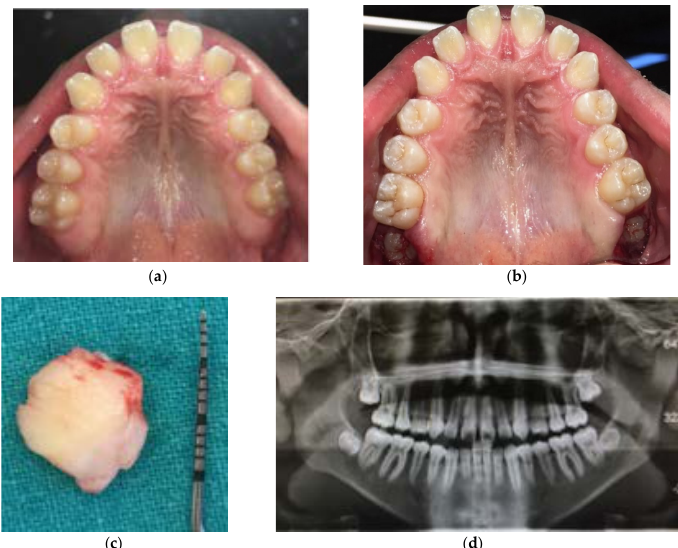
Figure 1. Example of a case treated with operculectomy. ( a ) Pre-surgical occlusal vision; ( b ) post-surgical occlusal vision; ( c ) example of the amount of soft tissue being removed in each side; ( d ) example of pre-treatment orthopantomography.